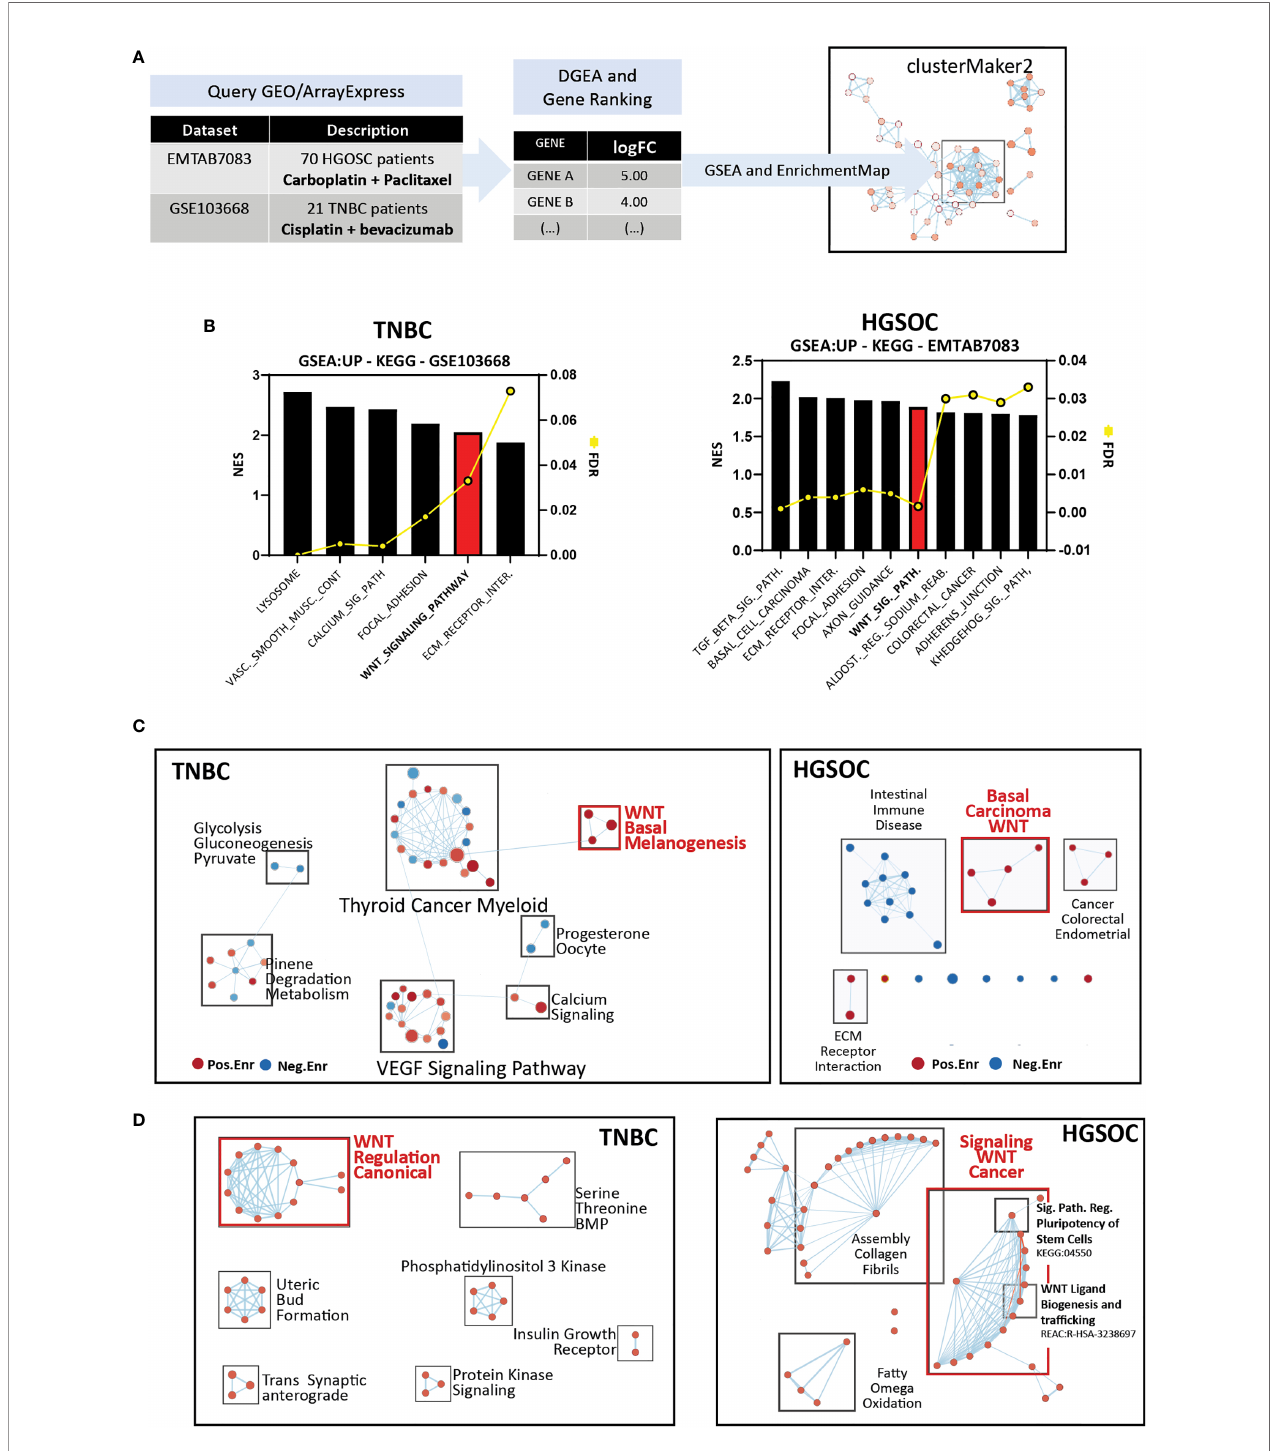
FIGURE 7 | Wnt signaling is deregulated in patients with platinum-resistant TNBCs, high-grade serous ovarian cancer, and isogenic cisplatin-resistant ovarian cancer cell lines. (A) Summary of datasets and analysis methodology used. Functional enrichment and mapping as previously reported (40, 41, 60). (B) Enriched KEGG gene sets in patients with platinum-resistant TNBC (left) and HGSOC (right). (C) Enrichment maps for visualization of enriched KEGG gene sets in patients with platinum-resistant TNBC (left) and HGSOC (right). (D) Enrichment maps for visualization of gPro fi ler functional enrichment analysis of ranked, upregulated DEGs in patients with platinum-resistant TNBC (left) and HGSOC